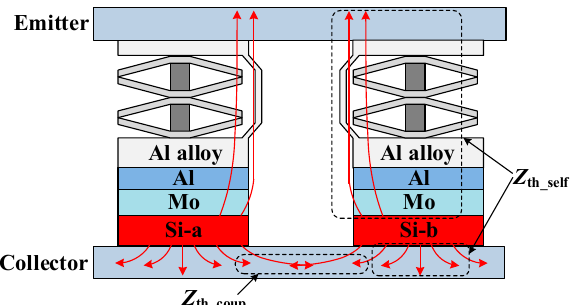
Figure 8. Heat flow path considering self-heating effect of single chip and coupling effect between paralleled chips.